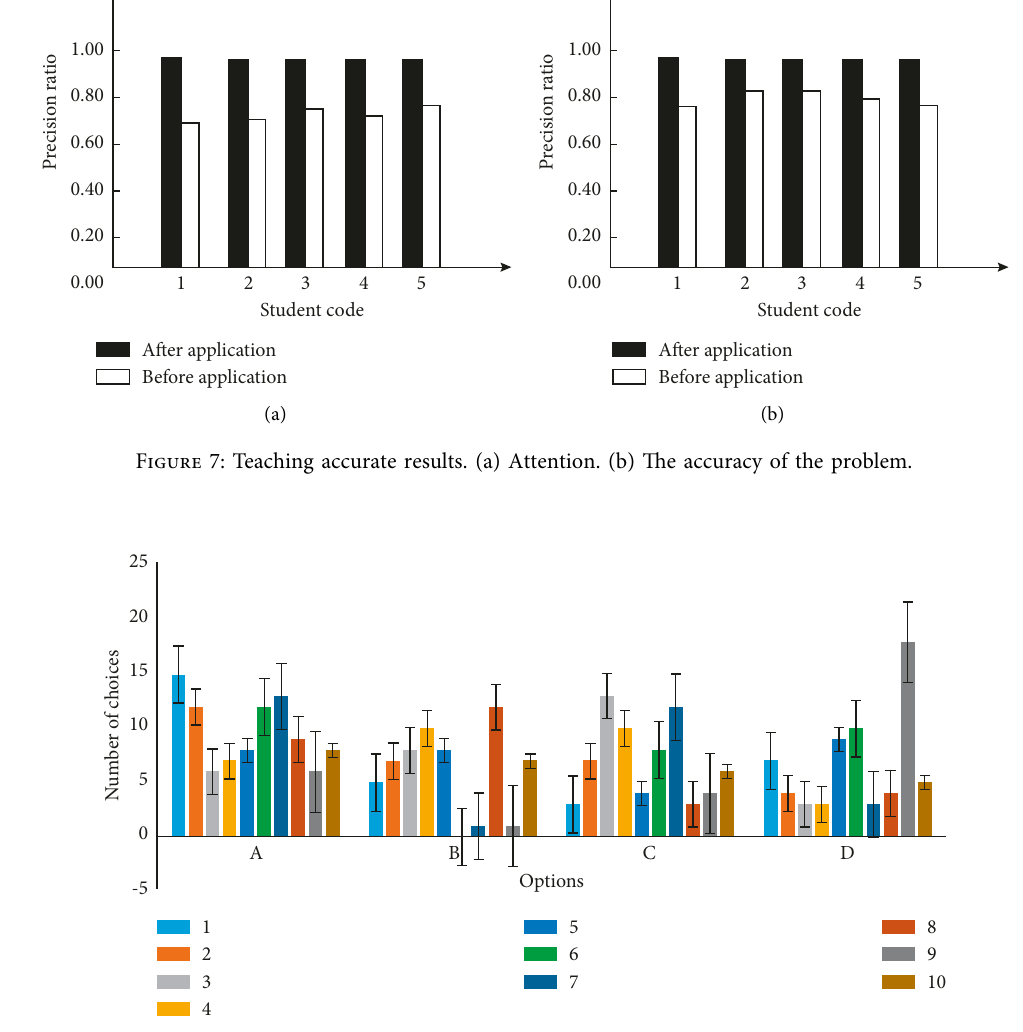
Figure 8: Visual results of students answering